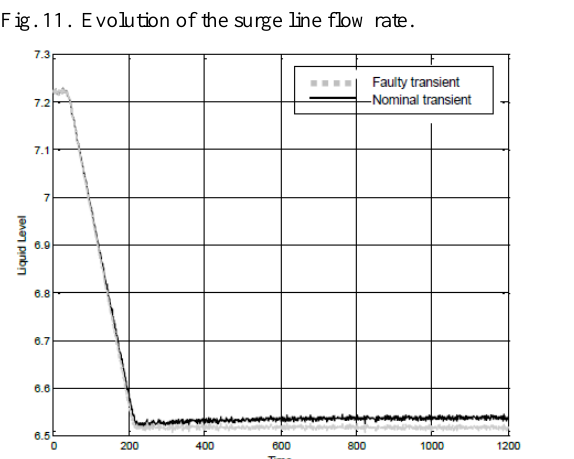
Fig. 11. Evolution of the surge line flow rate.